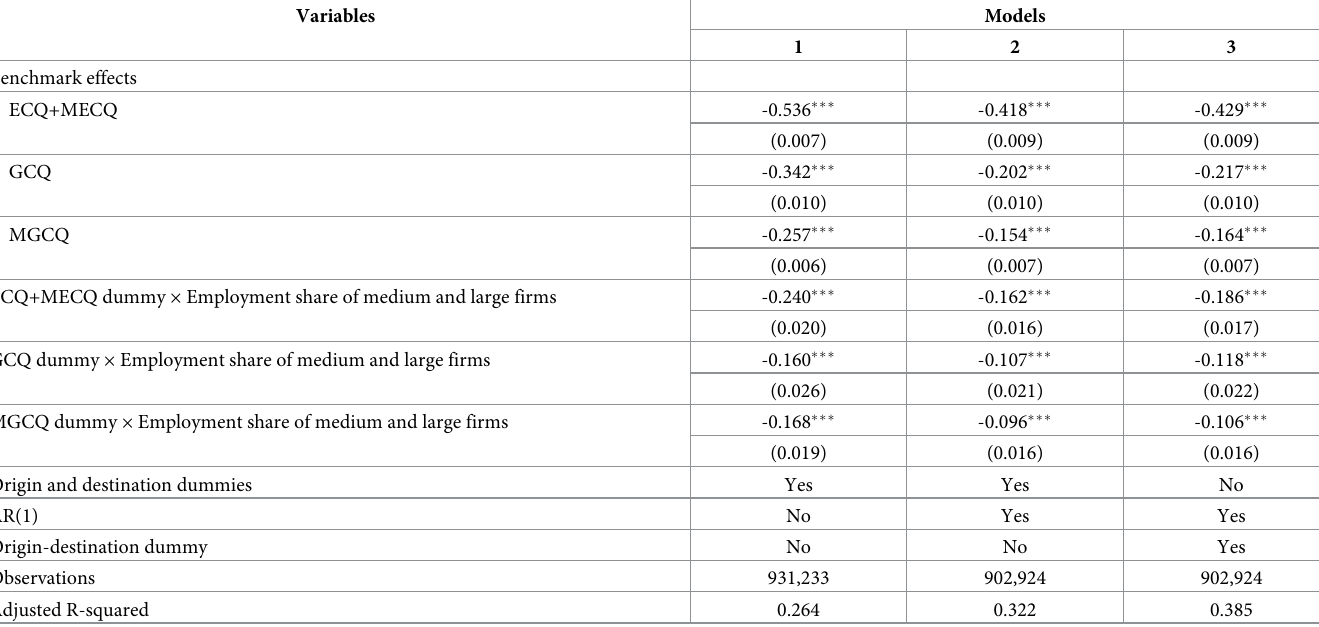
Table 3B. Effects of lockdown measures by destination city firm size composition (excluding within-barangay